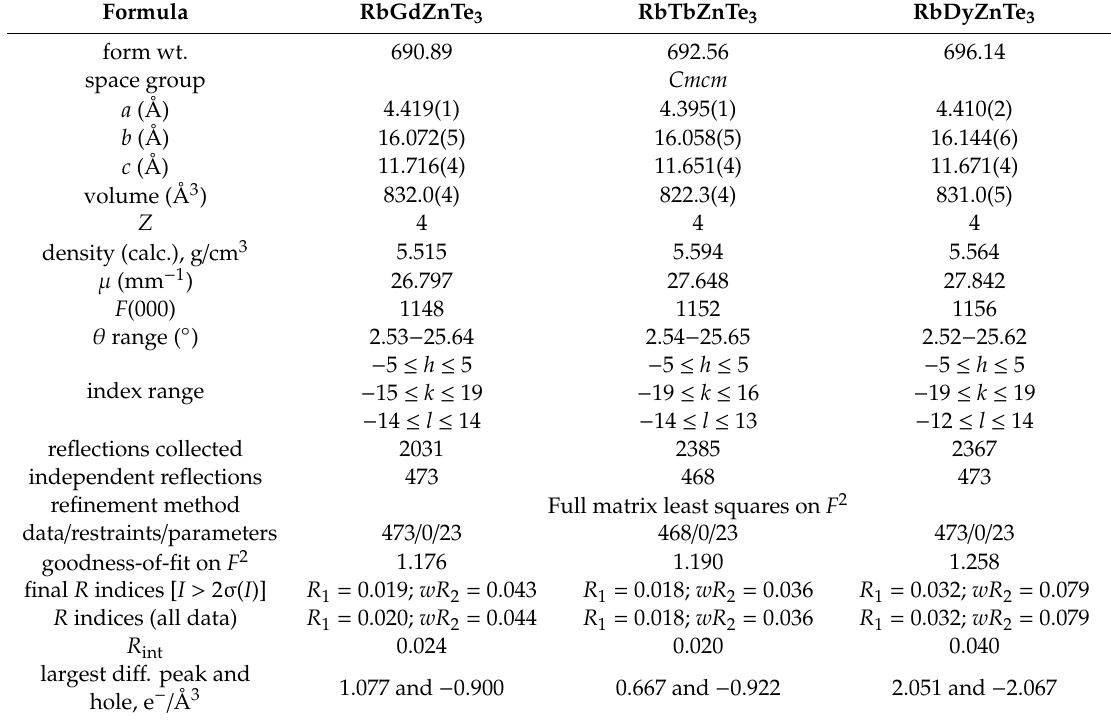
Table 1. Details of the crystal structure investigations and refinements for RbLnZnTe 3 (Ln = Gd, Tb, Dy). Formula RbGdZnTe 3 RbTbZnTe 3 RbDyZnTe 3 form